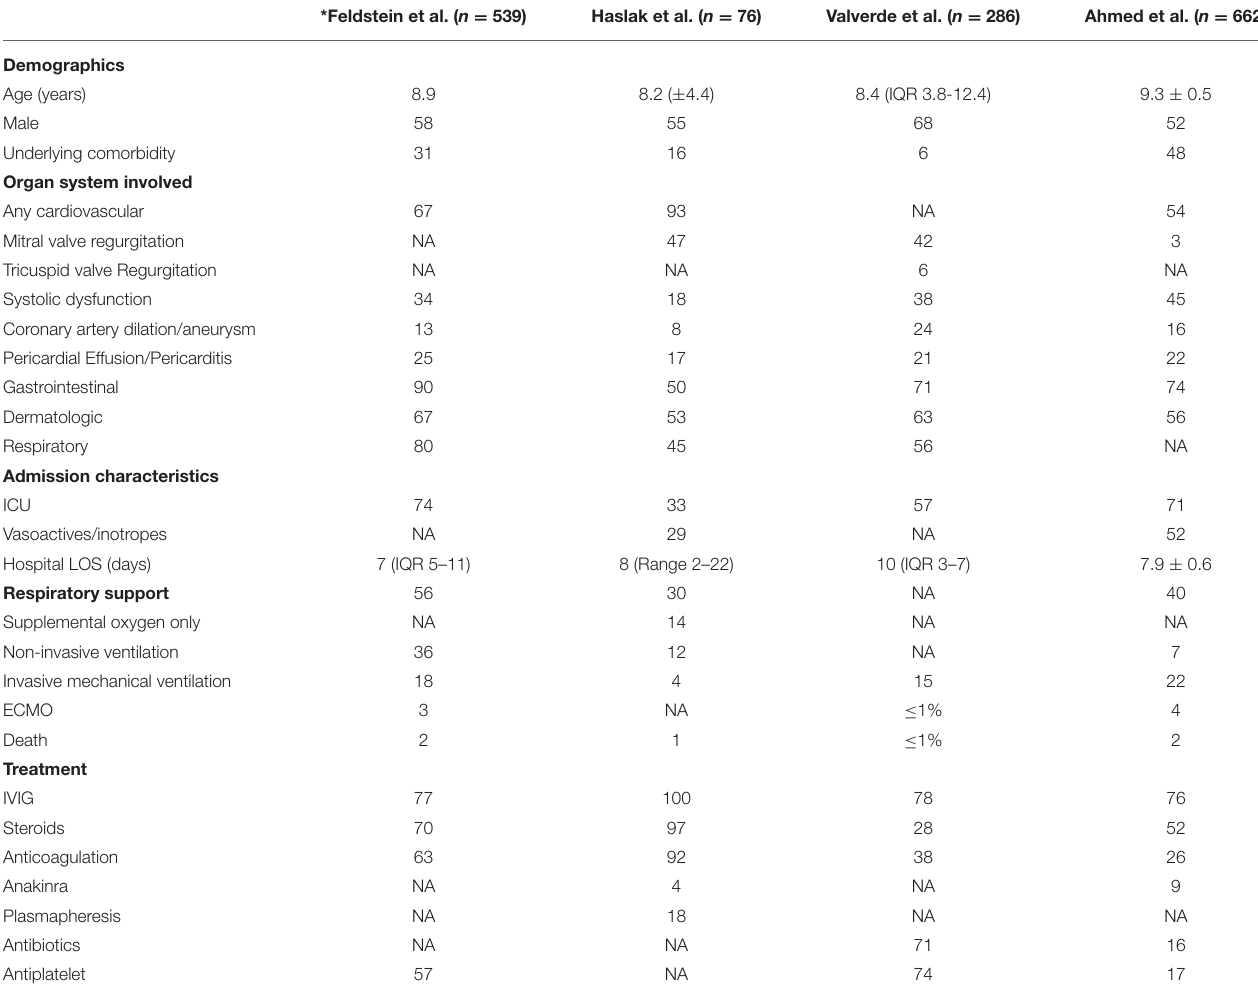
TABLE 1 | Acute Outcomes in Patients with MIS-C. *Feldstein et al. ( n = 539) Haslak et al. ( n = 76) Valverde et al. ( n = 286) Ahmed et al. ( n =